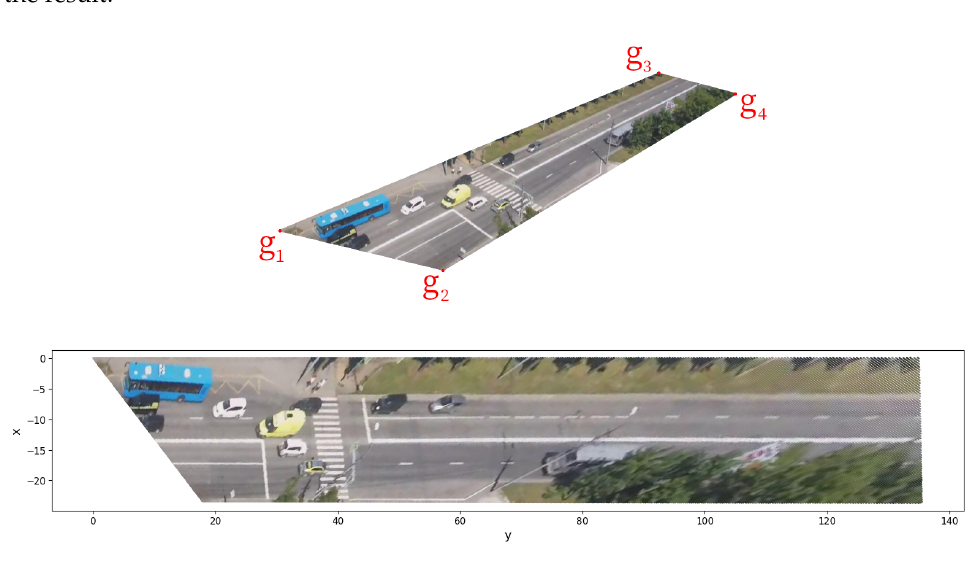
Figure 12. The Q π set visualization in plane Π for case